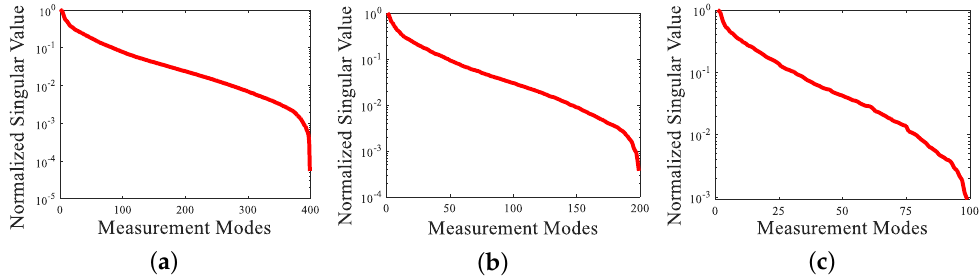
Figure 3. Singular values corresponding to the number of different measurement modes in the measurement matrix. ( a ) 400 (M/N = 0.1). ( b ) 200 (M/N = 0.05). ( c ) 100 (M/N =